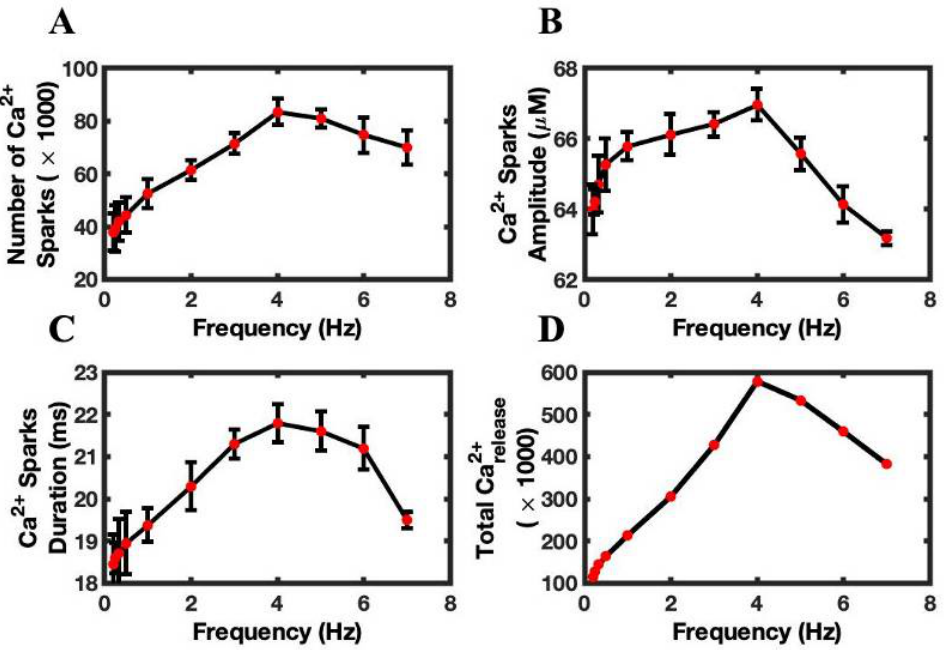
Figure 6. Ca 2+ spark frequency and amplitudes are better in predicting FFR. ( A ) Ca 2+ spark frequency. ( B ) Average Ca 2+ spark amplitude. ( C ) Ca 2+ spark duration. ( D ) Total Ca 2+ release approximated with the formula (0.5 × Ca 2+ spark amplitude × Ca 2+ spark duration).